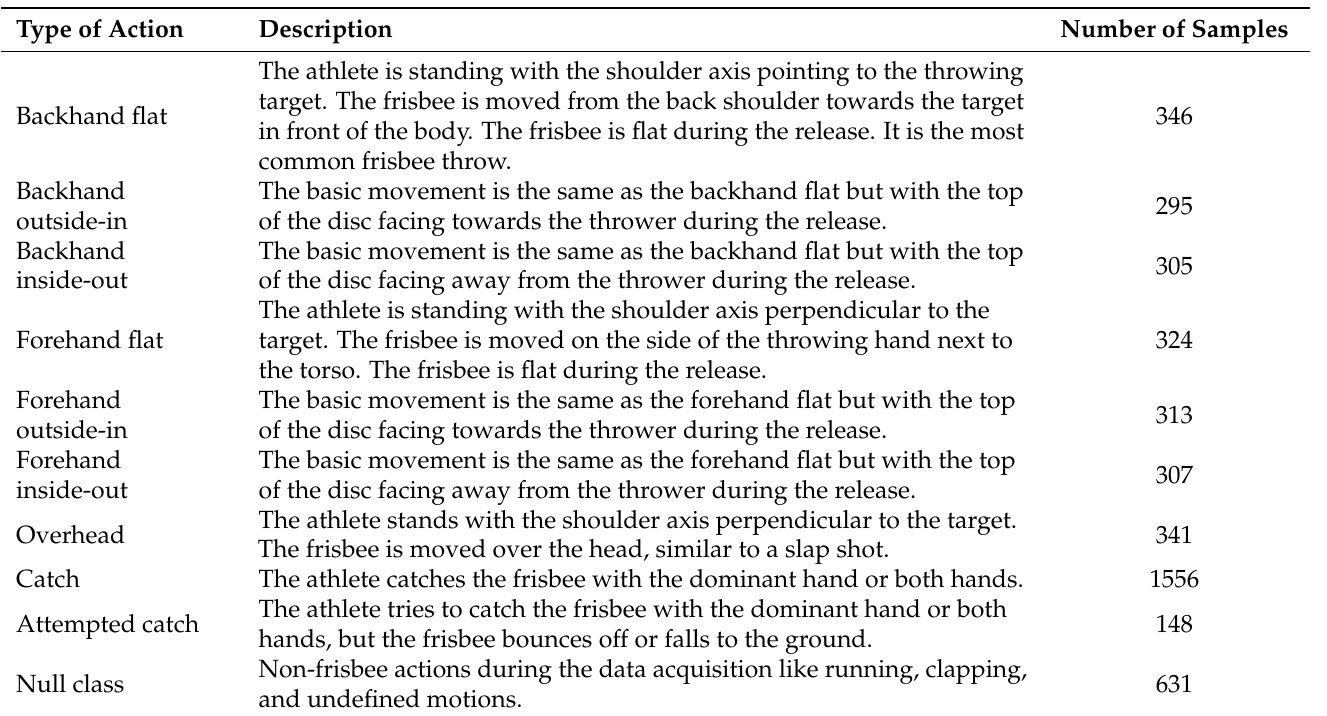
Figure 3. Depending on the angle of the release, the frisbee moves on a different trajectory. The different throwing types are shown for backhand throws. Table 2. Description of the Ultimate Frisbee action classes used in this study for throwing with the right hand. The different angles of the frisbee during the release affect the trajectory of the frisbee, which are the namesakes for the throwing technique. Additionally, the number of samples of the respective class is